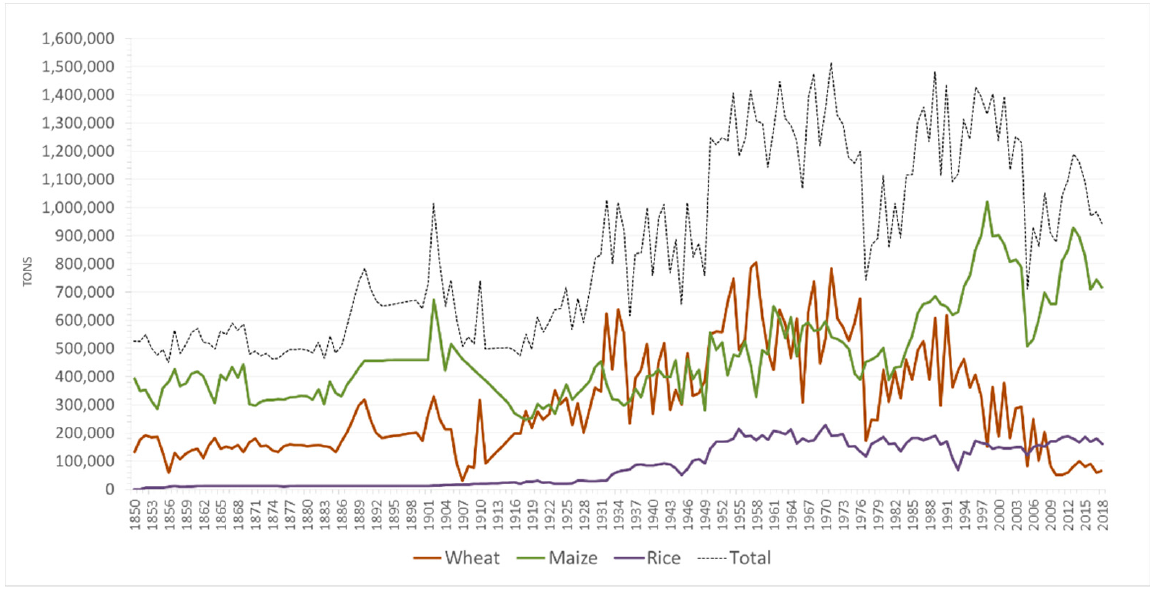
Figure 6. Wheat, maize, and rice national production during 1850–2018.